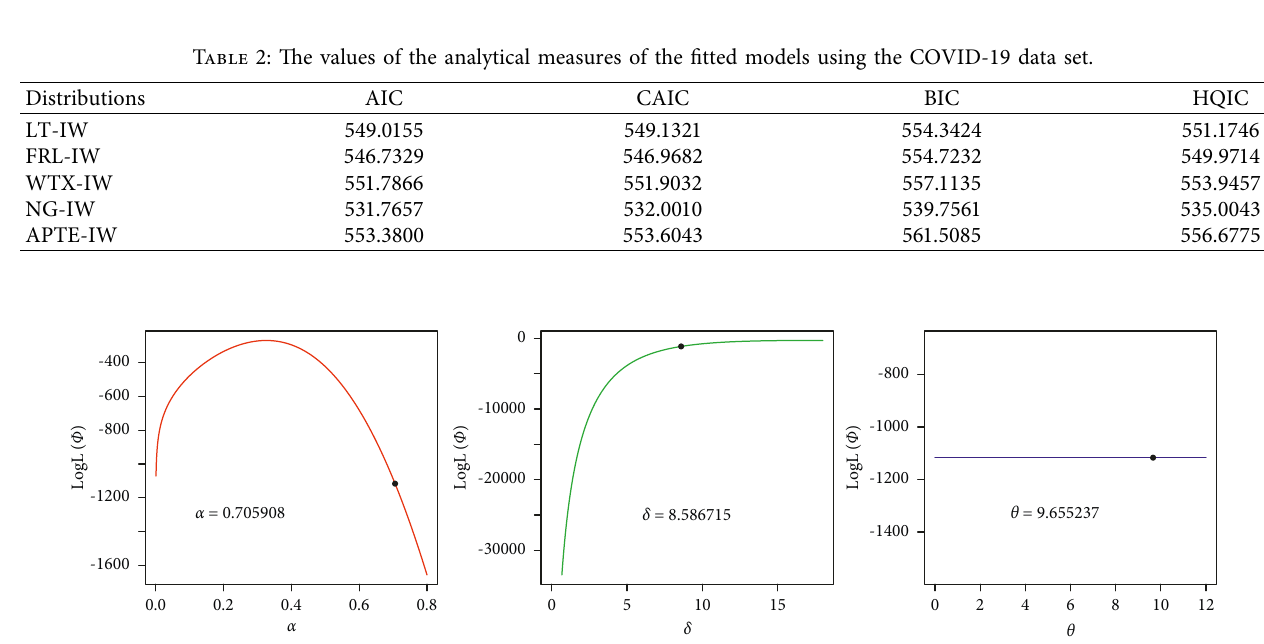
Figure 7: The profiles of the log LF of the NG-IW distribution using the COVID-19 data